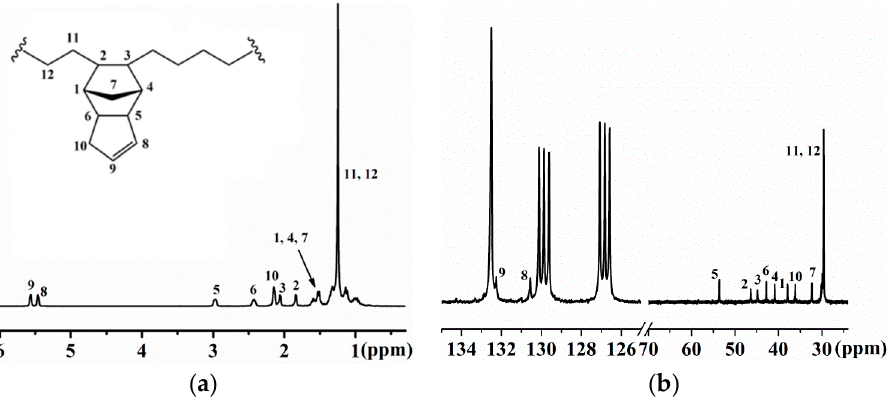
Figure 6. ( a ) 1 H spectrum and ( b ) 13 C spectrum of E/DCPD copolymer with DCPD of 15.7 mol % (entry 7 in Table 3) prepared by e /Et 2 AlCl/ETA catalytic system.